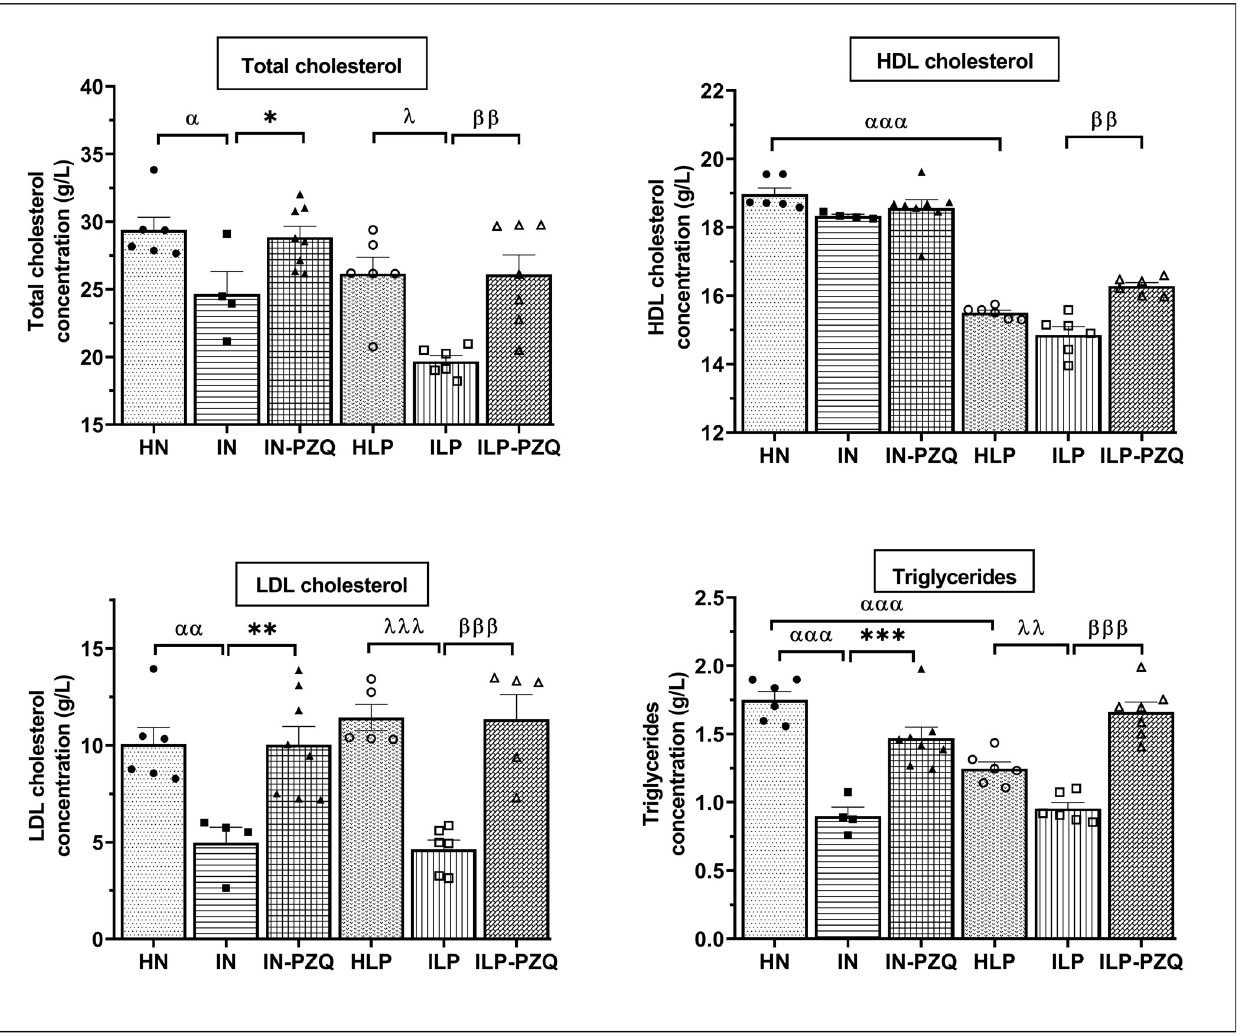
Fig 6. Effects of praziquantel treatment on the lipid profile of Schistosoma mansoni -infected mice receiving a low-protein diet. Data are expressed as mean ± SEM (n = 4–8). Group HN: healthy mice receiving a standard diet; group IN: infected-untreated mice receiving a standard diet; group IN-PZQ: infected mice receiving a standard diet and treated with praziquantel; group HLP: healthy mice receiving a low-protein diet; group ILP: infected-untreated mice receiving a low-protein diet; group ILP-PZQ: infected mice receiving a low-protein diet and treated with praziquantel. ANOVA followed by Turkey multiple comparison test. α P < 0.05; αα P < 0.01; ααα P < 0.001: values are significantly different from healthy mice receiving a standard diet (group HN). � P < 0.05; �� P < 0.01; ��� P < 0.001: values are significantly different from infected-untreated mice receiving a standard diet (group IN). λ P < 0.05; λλ P < 0.01 λλλ P < 0.001: values are significantly different from healthy mice receiving a low-protein diet (group HLP). ββ P < 0.01; βββ P < 0.001: values are significantly different from infected-untreated mice receiving a low-protein diet (group